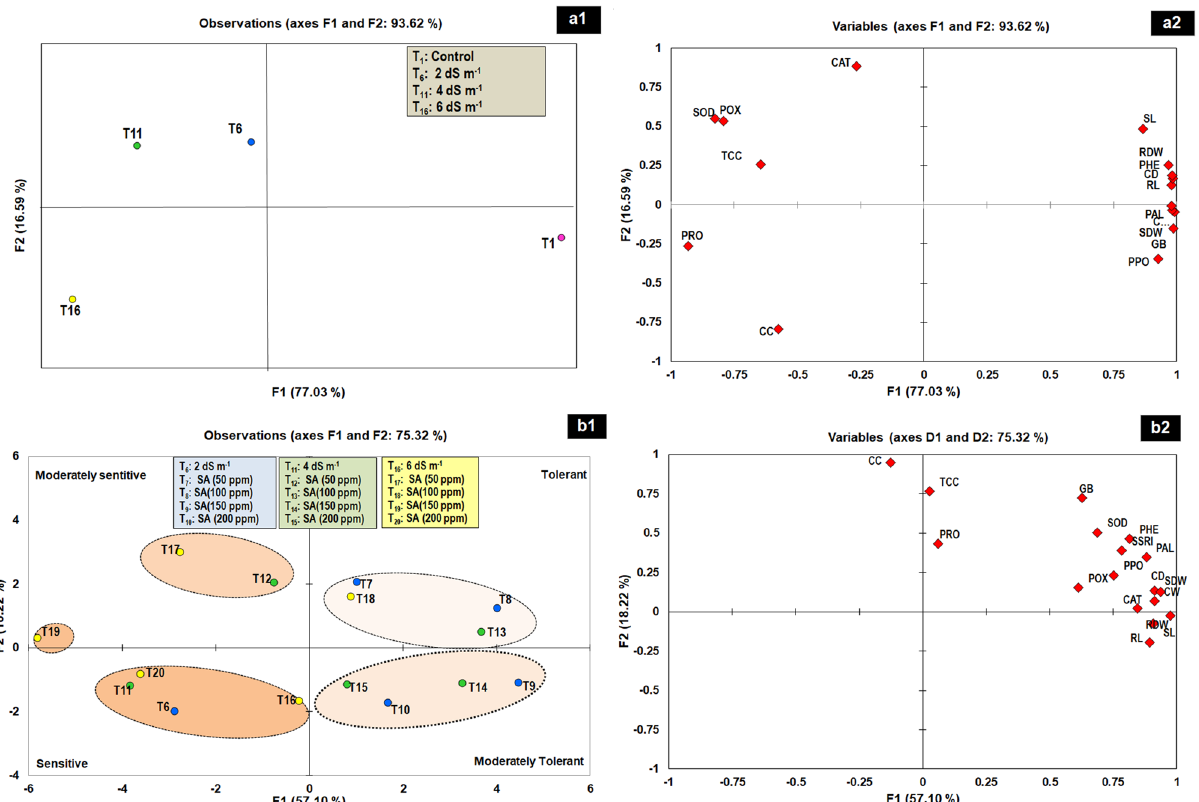
Figure 7. ( a,b ) Biplot representation of the results of principal component analysis (PCA) describing effect of salinity and salicylic acid (SA) ( a ) Treatments response to salinity stress ( a 1 ) based on measured properties of the plant ( a 2 ); classification of treatments into different salt tolerant groups (salt sensitive, low, moderate, and high salt tolerant) ( b 1 ) based on all the morpho-physiological parameters ( b 2 ). SL shoot length; SDW shoot dry weight; RL root length; RDW root dry weight; CD corm diameter; CW corm weight; TCC total chlorophyll content; CC carotenoids; Pro proline; GB glycine betaine; PHE total phenolics; SOD superoxide dismutase; CAT catalase; POX peroxidase; PPO polyphenol oxidase; PAL phenylalanine ammonia